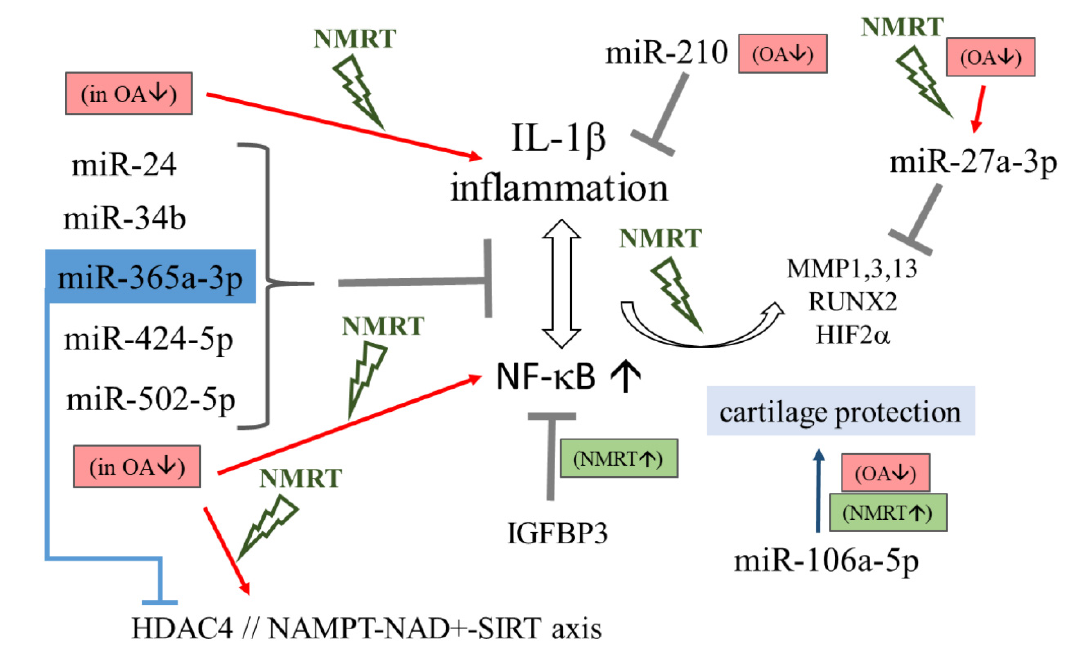
Figure 6. Schematic description of miRs influencing inflammation and NF-kB signaling and the gateways where NMRT might interfere. MiRs are listed and their capacity in controlling gene expression under normal conditions as described in the literature and can be deduced from our results, is depicted by the grey T bar. Repression of miRs in OA chondrocytes (OA ↓ ) can intensify inflammation and NF-kB activity (red arrows) while these effects were counteracted by NMRT (signed in green); improvements by NMRT are also presented (NMRT ↑ ). The connection between miR-365 and HDAC4 is marked in blue.